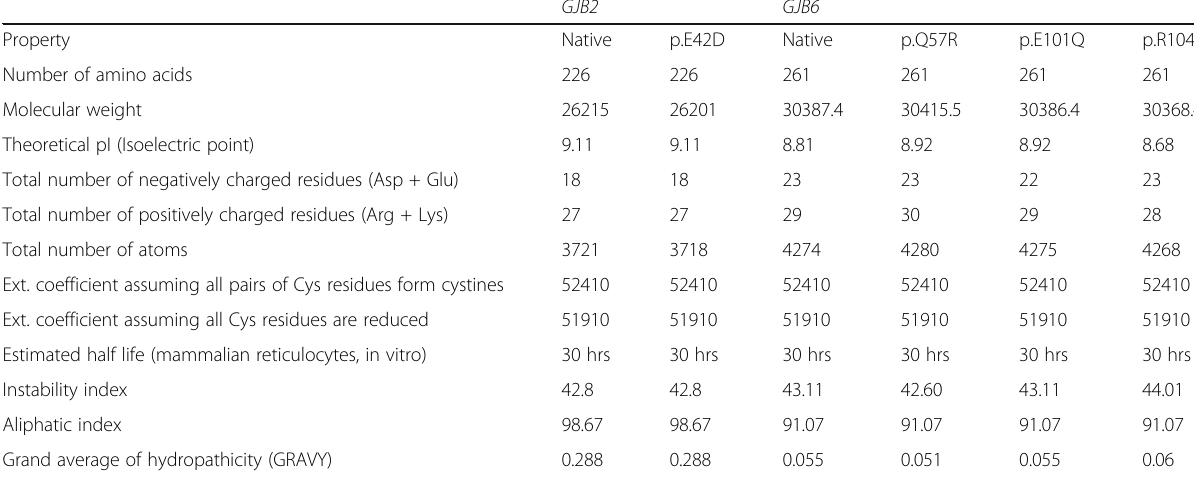
Table 12 Comparison of native and the mutant structure with p.E42D variant in Cx26 protein using Expasy ’ s ProtParam tool GJB2